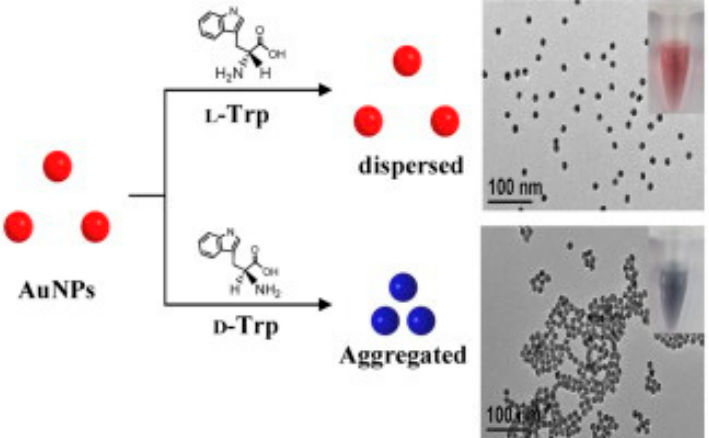
Figure 8. TEM images of the effect of Trp addition to a solution of citrate-capped Au NPs. Reprinted with permission from [83], Copyright Elsevier,